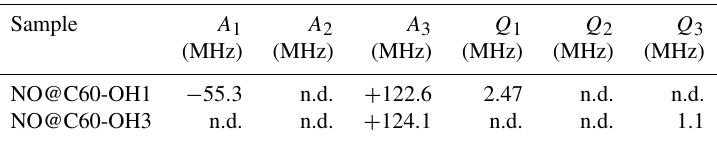
Table 2. Hyperfine parameters determined by fitting Davies ENDOR spectra measured under orientation selection conditions providing the best resolution. For an assignment of signs, see text. n.d.: not determined.